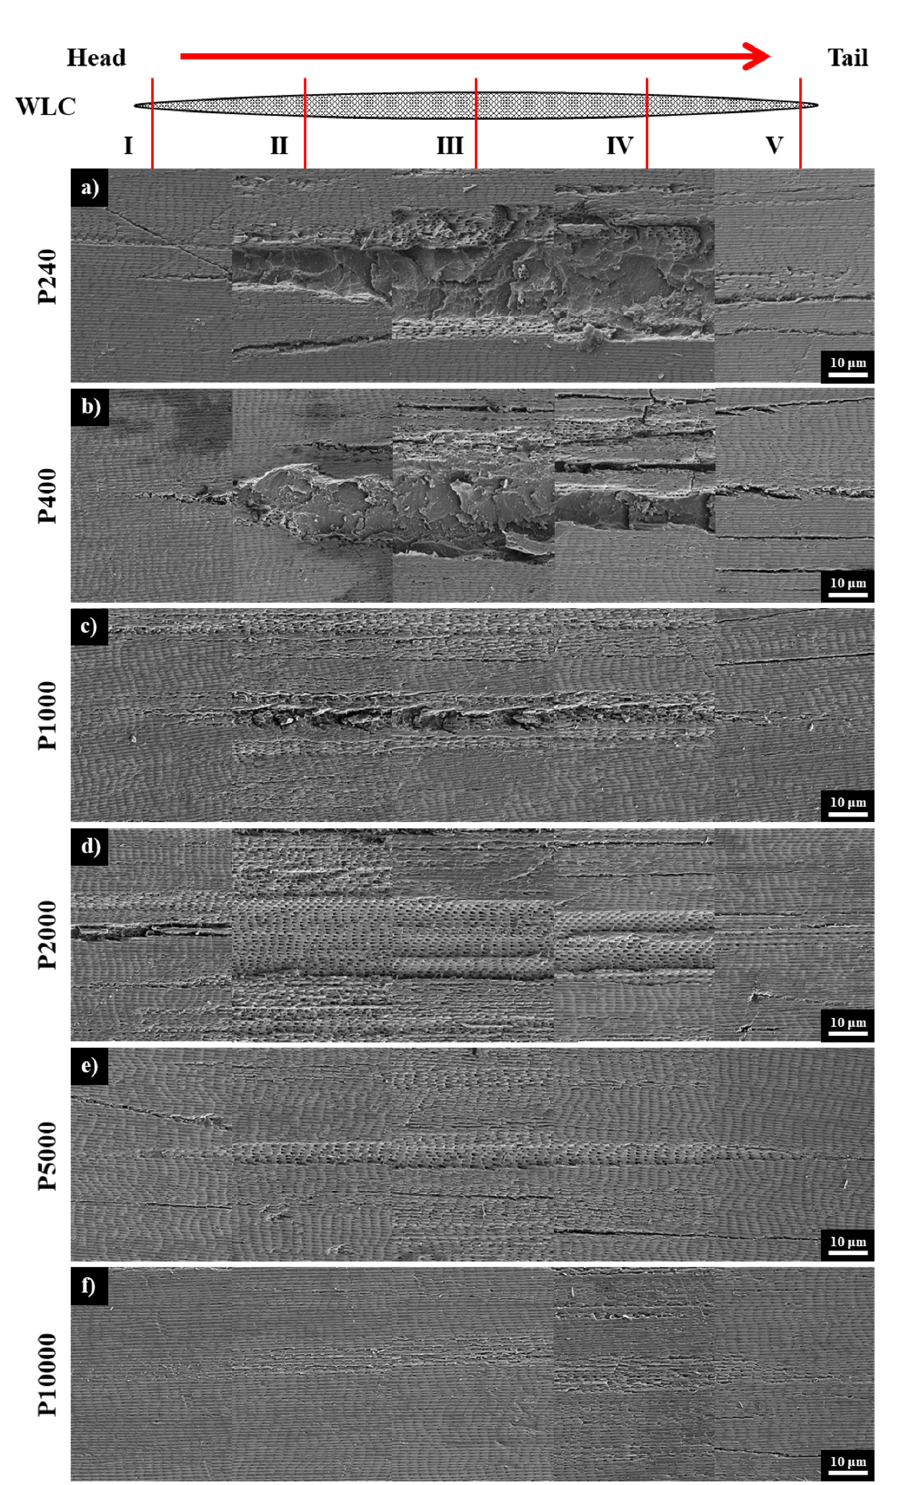
Figure 7. Comparison of wear scar in WLC between ( a ) P240, ( b ) P400, ( c ) P1000, ( d ) P2000, ( e ) P5000, and ( f ) P10000 (5 kV, 5000×). The red arrow indicates the scratch direction.